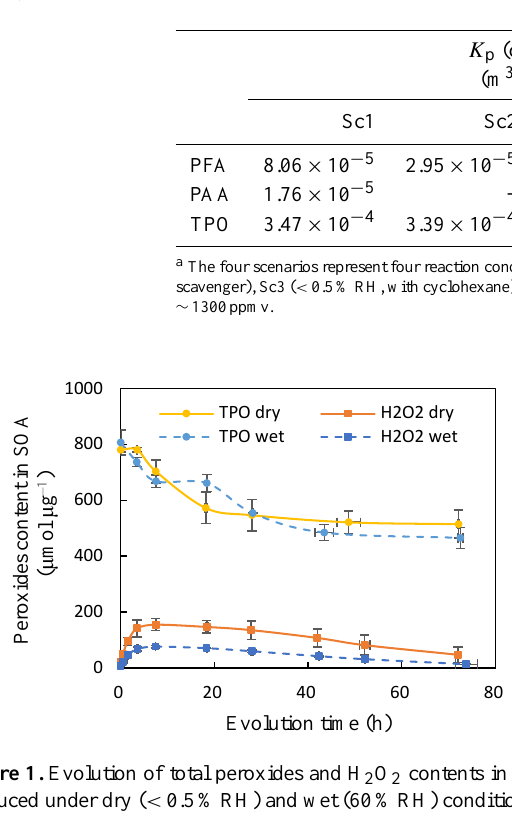
Table 2. Comparison of observed and theoretical gas-particle partitioning coefficients ( K p ) of PFA, PAA, and TPO at different scenarios (298K).